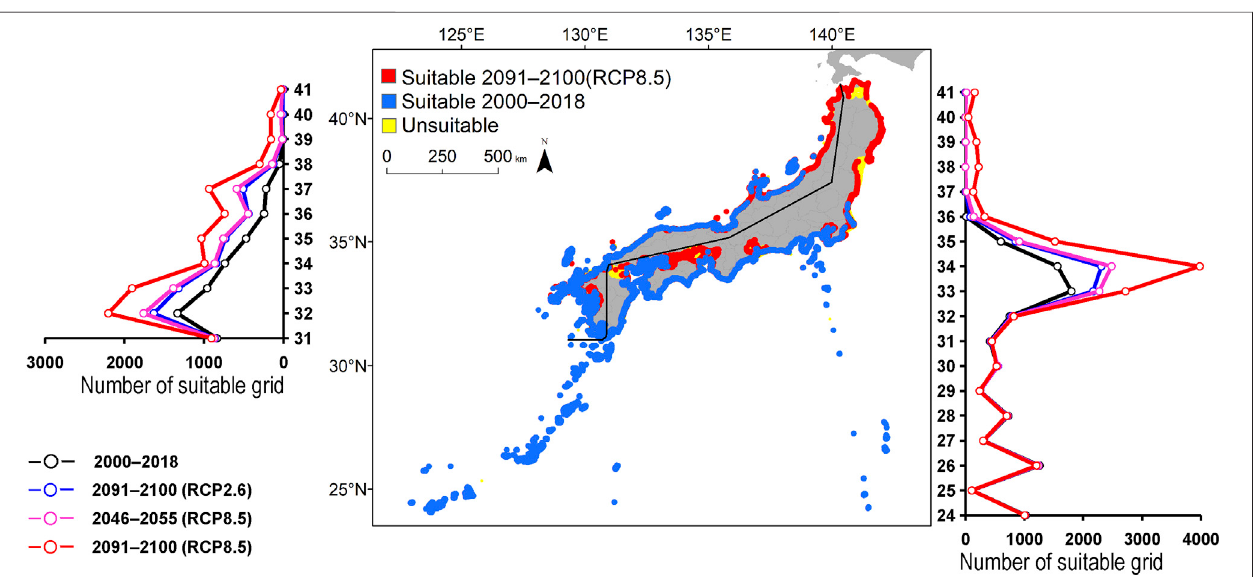
FIGURE2| Estimateddistributionof Aluterusscriptus .Themapsshowtheirdistributionchangesbetween2000 – 2018and2091 – 2100(forRCP8.5scenario).The line graphs represent the estimated number of suitable grids by latitude in 2000 – 2018 (black line) and predicted distribution in 2091 – 2100 based on the RCP2.6 scenarios(blueline), 2046 – 2055(forRCP8.5scenario;pinkline),and2091-2100 (forRCP8.5scenario;redline).TheleftlinegraphshowsthecoastoftheSeaofJapan, and the right bar graph shows the coast of the Paci fi c Ocean.